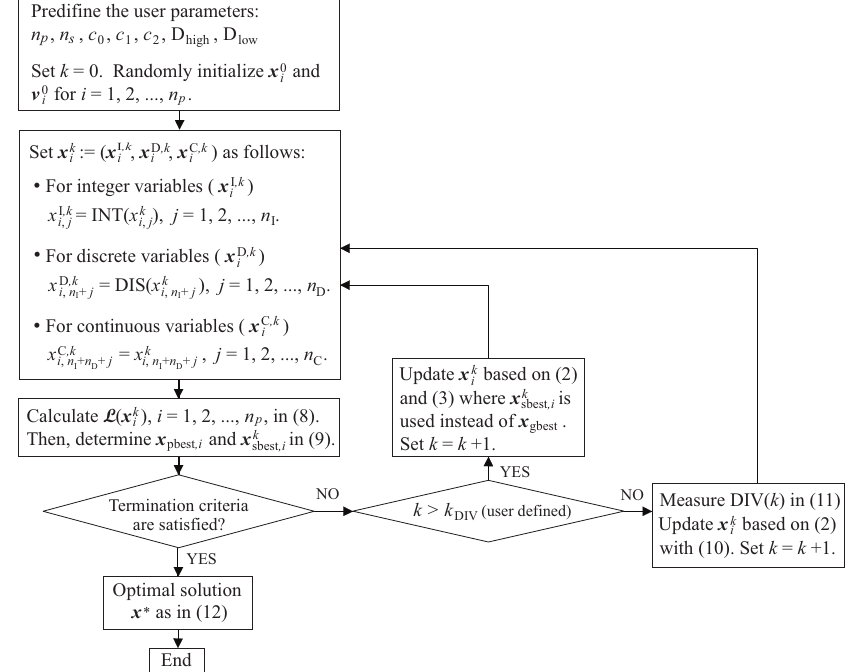
Figure 2. Flowchart of the PSO scheme with a diversity classifier for cyclically neighboring subpopulations for solving the constrained MIDC optimization